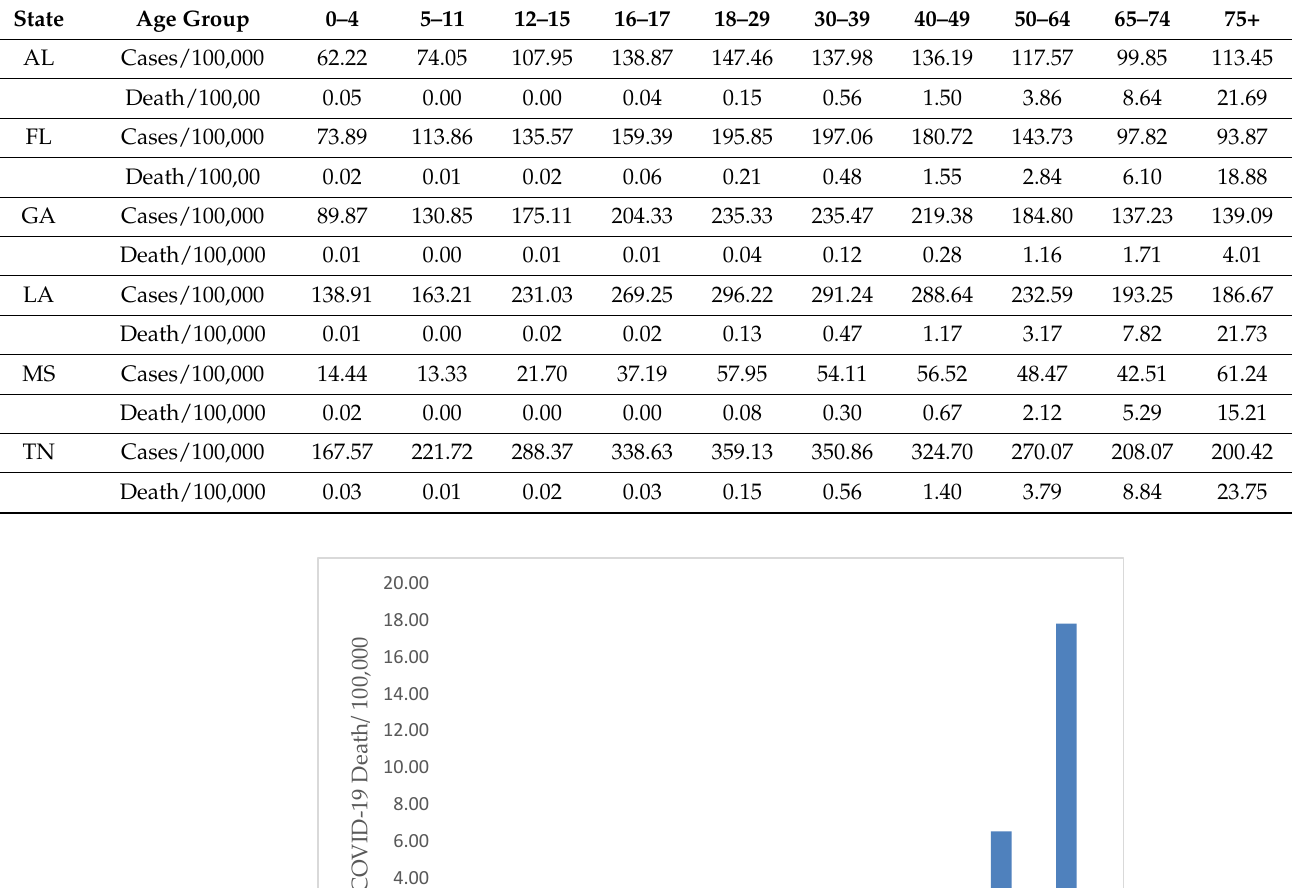
Figure 6. Average COVID-19 cases by age group in all states from 2020 to 2022. The highest rates were found among the 18–29- and the 30–39-year age groups. Table 2. Rates of COVID-19 cases and deaths by age group in the selected states from January 2020 through February 2022.